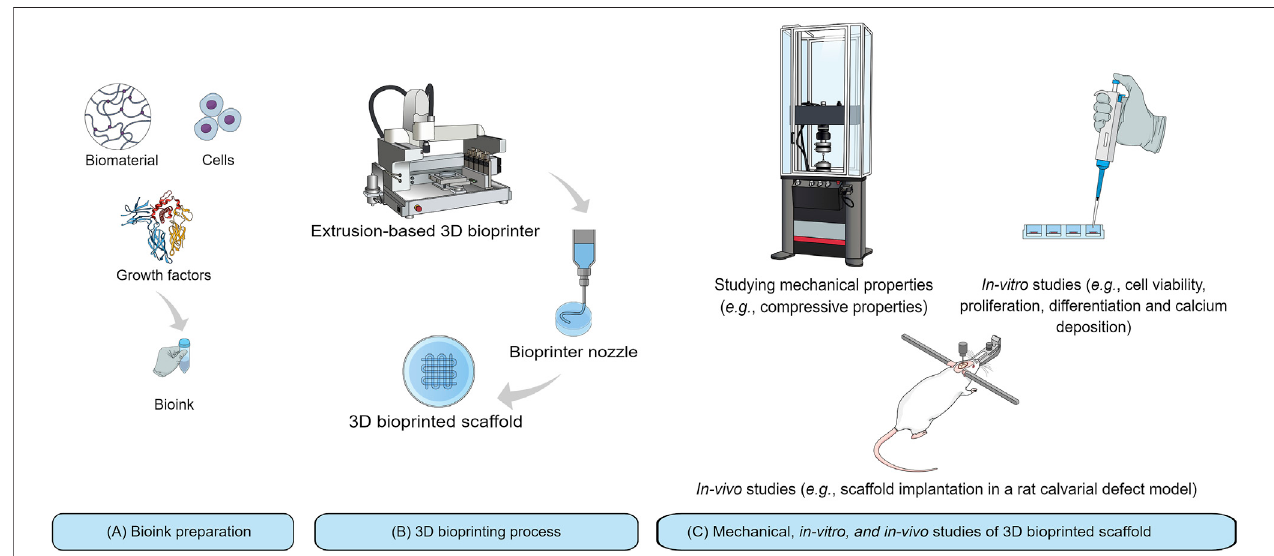
FIGURE2 | Schematic representation of3D bioprinting technique and its application forBTE: (A) Bioink preparation from three componentsincludingbiomaterial, growth factor, and cells; (B) Bioprinting process with an extrusion-based 3D bioprinter; and (C) Mechanical, in-vitro , and in-vivo studies.